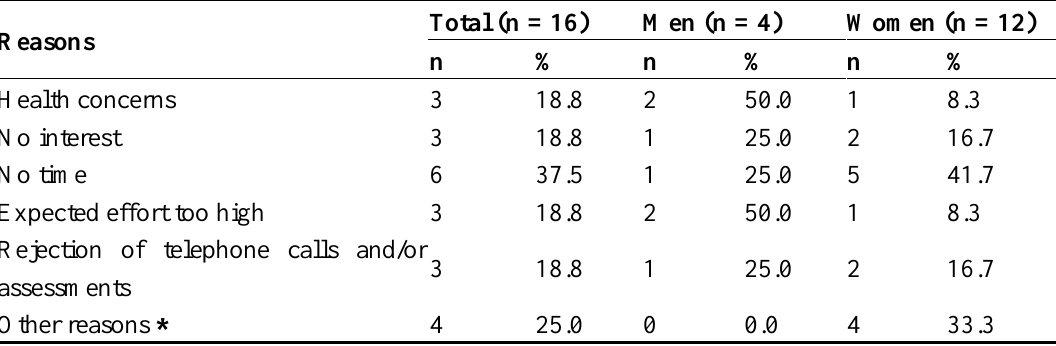
Table 3. Eligible patients not willing to participate: reasons for non-participation (multiple answers